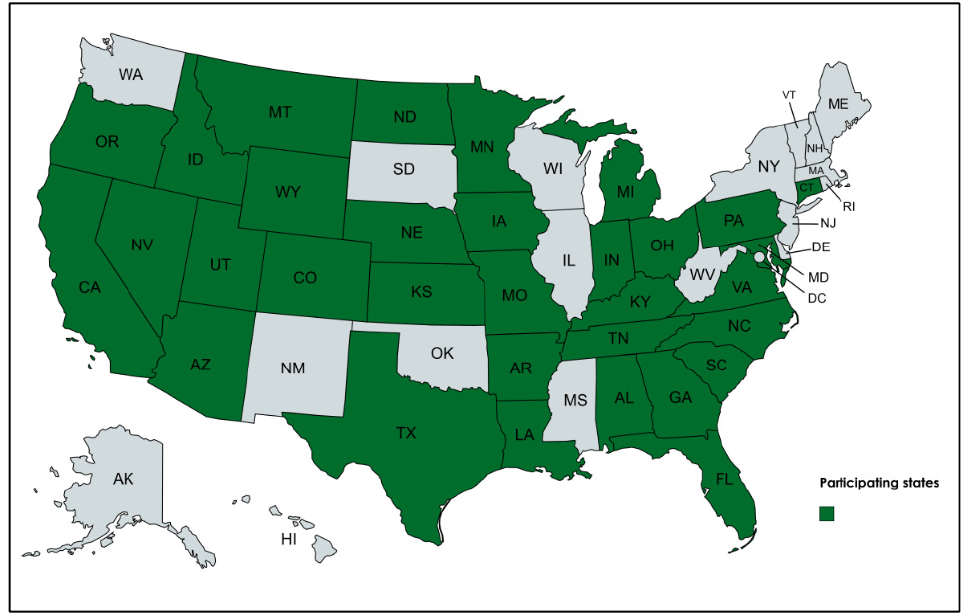
Figure 1. Participating states in the Pavement Friction Management (PFM) survey of practice.